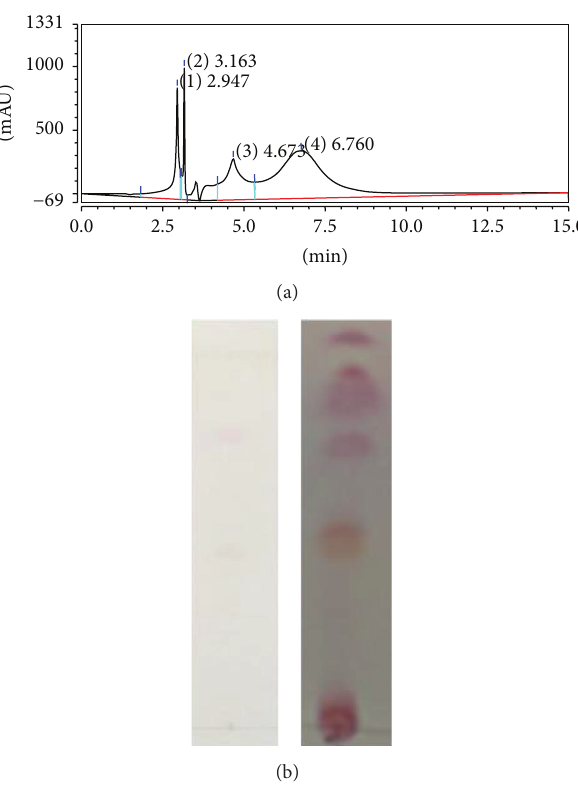
Figure 2: (a) PREP-HPLC profile of the crude peptides from B. niabensis 45. (b) TLC chromatogram of peak P2 before (left) and after (right) hydrochloric acid hydrolysis.